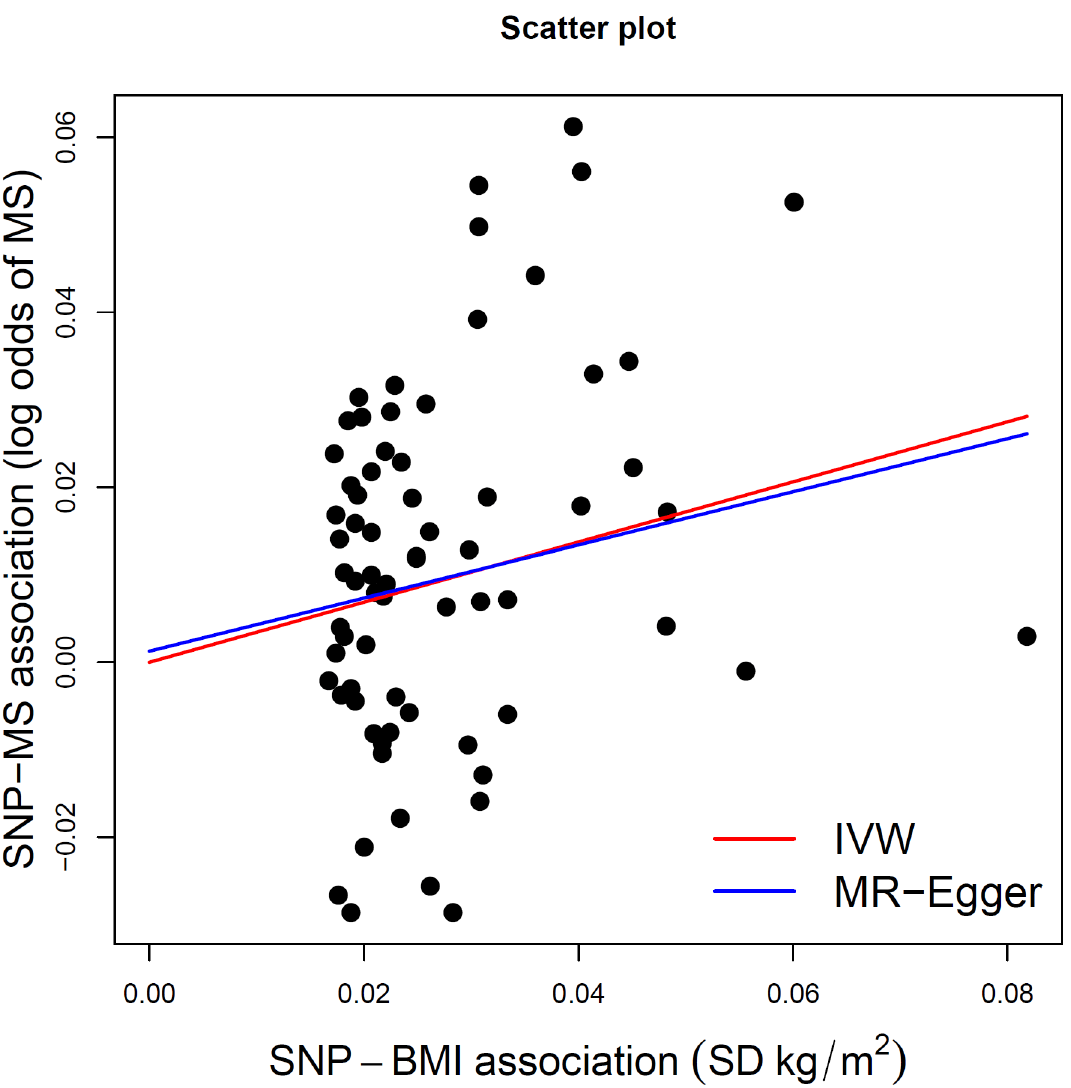
Fig 2. MR-Egger regression scatterplot for BMI on MS analysis. The red line shows the results of standard MR analysis (inverse-variance weighting [IVW]), and the blue line shows the pleiotropy-adjusted MR-Egger regression line. The estimated slope of the MR-Egger regression, expressed as an OR, was 1.35 (95% CI 0.91 – 2.02). The estimated MR-Egger intercept term was 0.0013 (95% CI − 0.010 – 0.013)